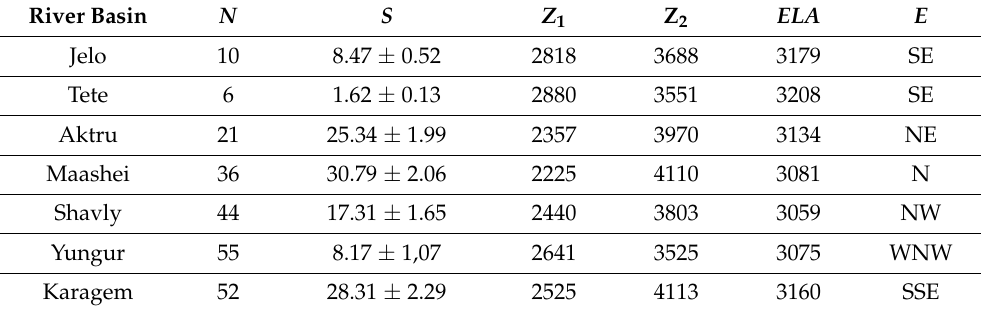
Table 7. Glaciers of North-Chuya ridge in 2021. Abbreviations are given in Table 5. River Basin N